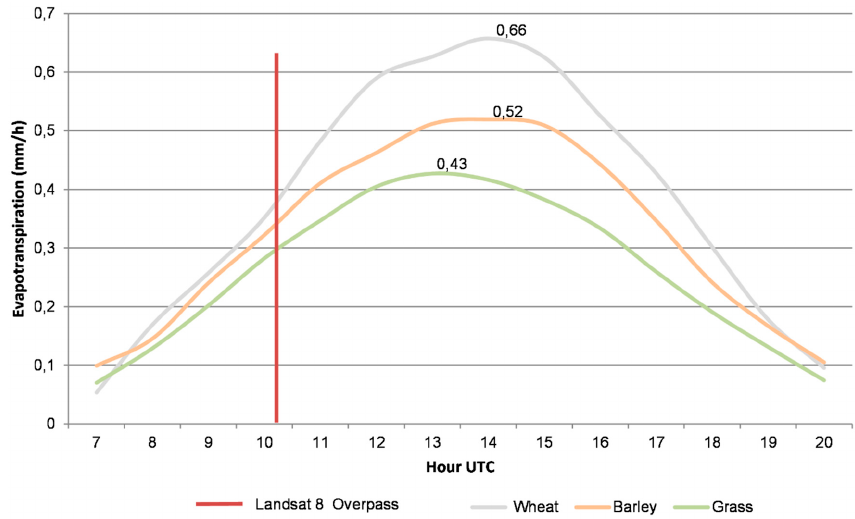
Figure 5. Hourly ET (mm/h) obtained from in situ lysimeter data for Grass, Wheat, and Barley. The red line indicates the overpass time of Landsat 8 at 10:42 UTC. Overall, the ET exhibits typical fluctuations in shape during the day, varying between 7:00 and 20:00 UTC. The hourly ET for Grass ranged from 0.03 mm/h to 0.43 mm/h, with an hourly average of 0.24 mm/h and its maximum value at 13:00 UTC. For Wheat, the hourly ET ranged from 0.04 mm/h to 0.66 mm/h, with an hourly average of 0.36 mm/h and its maximum value at 14:00 UTC. Finally, for Barley, the hourly ET ranged from 0.05 mm/h to 0.52 mm/h, with an hourly average of 0.30 mm/h and its maximum value at 14:00 UTC. Yang et al. [52] reported noticeable daytime ET variations between 7:00 and 18:00, with a peak typically occurring at approximately 14:00